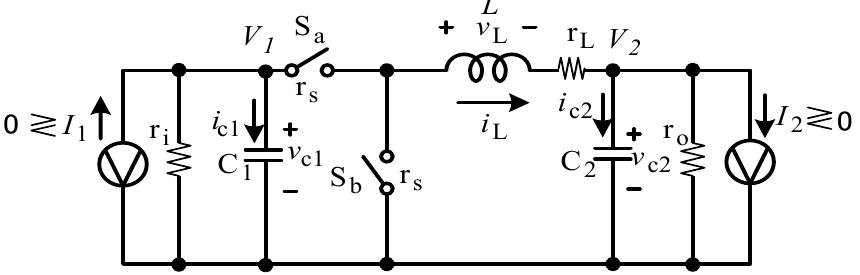
Figure 5. Main circuit topology: non-isolated bi-directional DC–DC converter based DCSOP. C 2 and L .